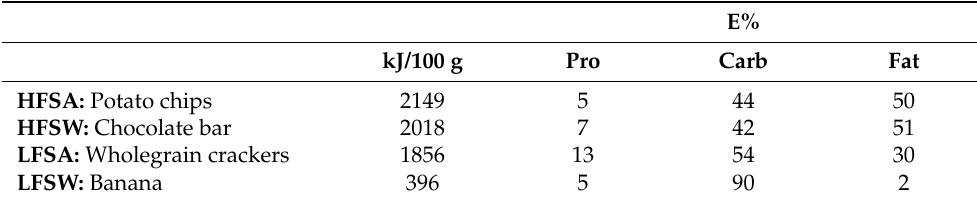
Figure 2. Selection of snack products as presented to study participants. Table 3. Macronutrient content of snack-food selection. Table 3. Macronutrient content of snack-food